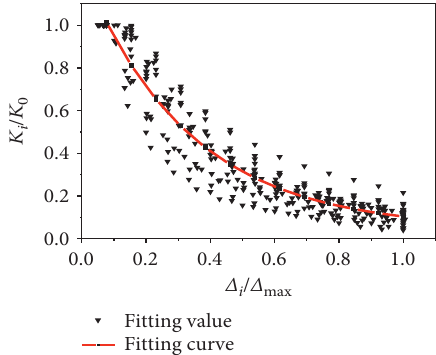
i / K 0 and Δ i / Δ max .